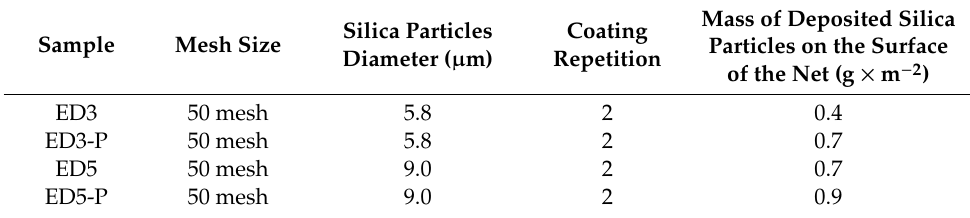
Table 1. Properties of the silicon coated nets ED3 (without para ffi n), ED3-P (para ffi n), ED5 (without para ffi n), and ED5-P (para ffi